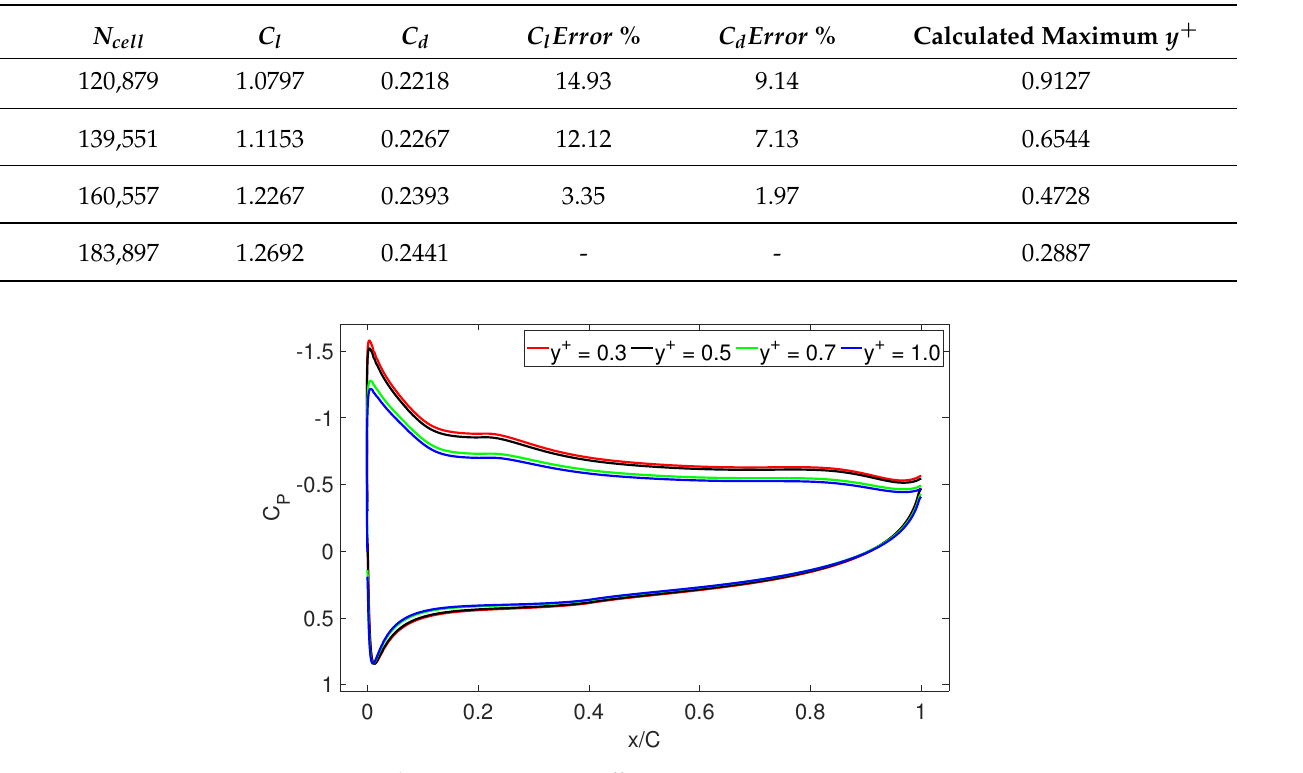
Figure 6. Baseline case pressure coefficient